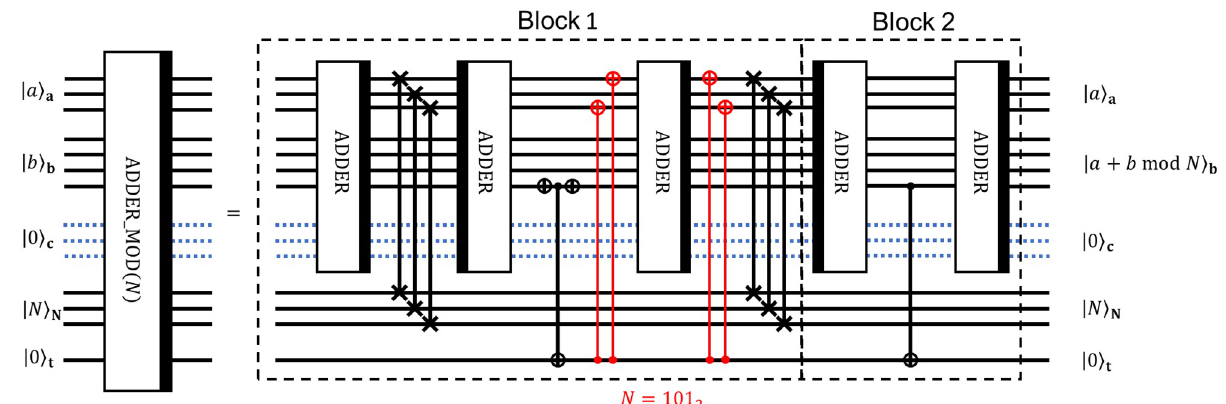
Fig 5. Decomposition of ADDER_MOD circuit into lower-level operations. The decomposition realizes modular addition of two 3-bit integers a and b modulo 3-bit integer N .